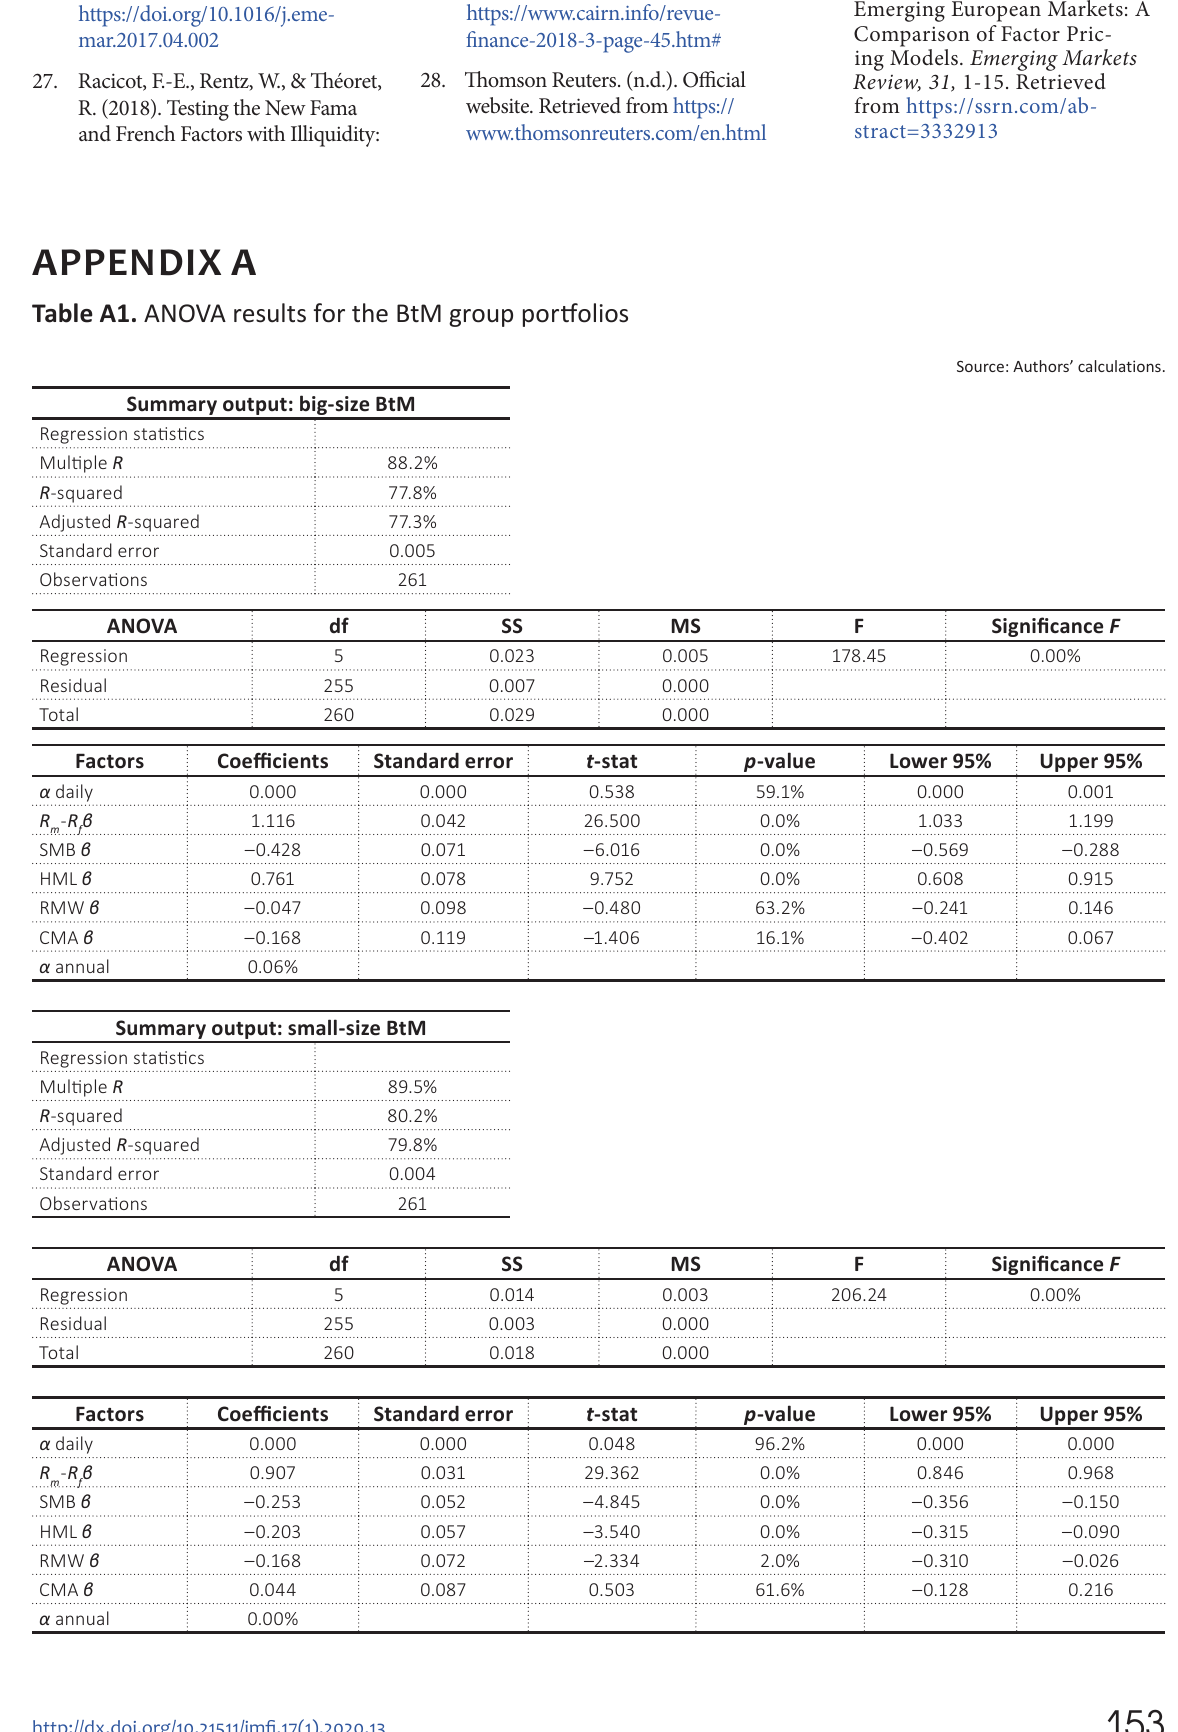
Table A1. ANOVA results for the BtM group portfolios